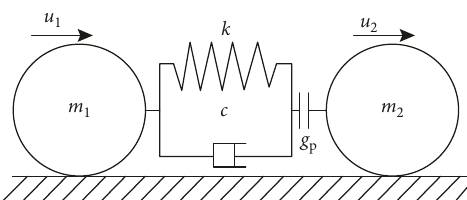
Figure 1: Equivalent model of pounding between two colliding